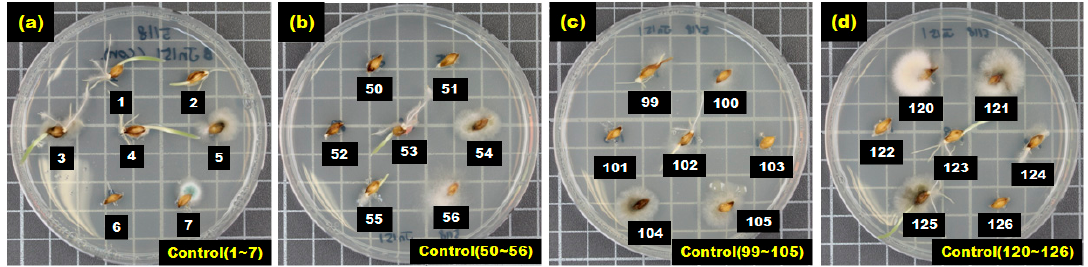
Figure 5. Culture results for hulled barley (JN151) in the control group, showing that Fusarium was not observed.